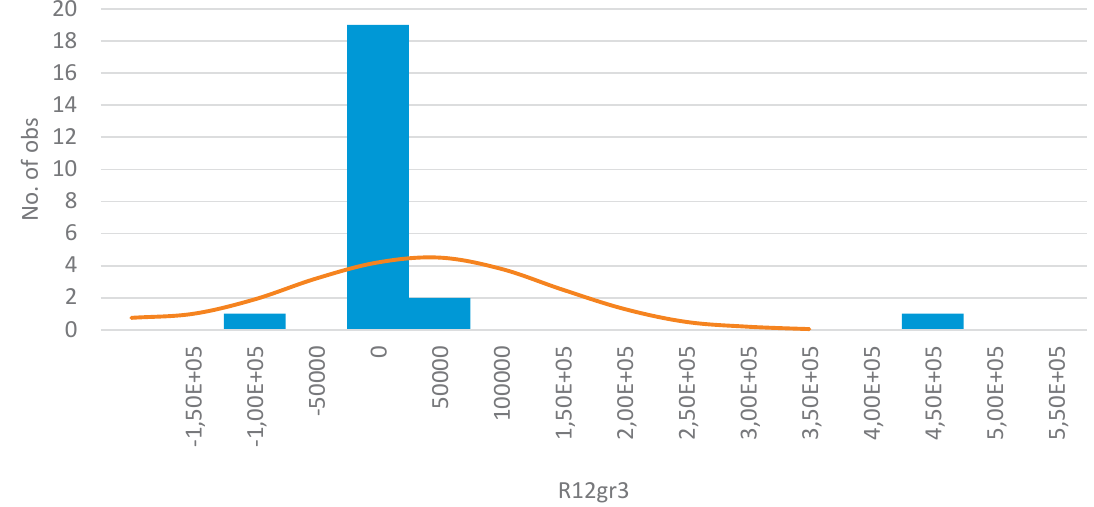
(cid:94)(cid:381)(cid:437)(cid:396)(cid:272)(cid:286)(cid:855)(cid:3)C(cid:258)(cid:367)(cid:272)(cid:437)(cid:367)(cid:258)(cid:410)(cid:286)(cid:282)(cid:3)(cid:271)(cid:455)(cid:3)(cid:410)(cid:346)(cid:286)(cid:3)(cid:258)(cid:437)(cid:410)(cid:346)(cid:381)(cid:396)(cid:400)(cid:3)(cid:271)(cid:258)(cid:400)(cid:286)(cid:282)(cid:3)(cid:3)